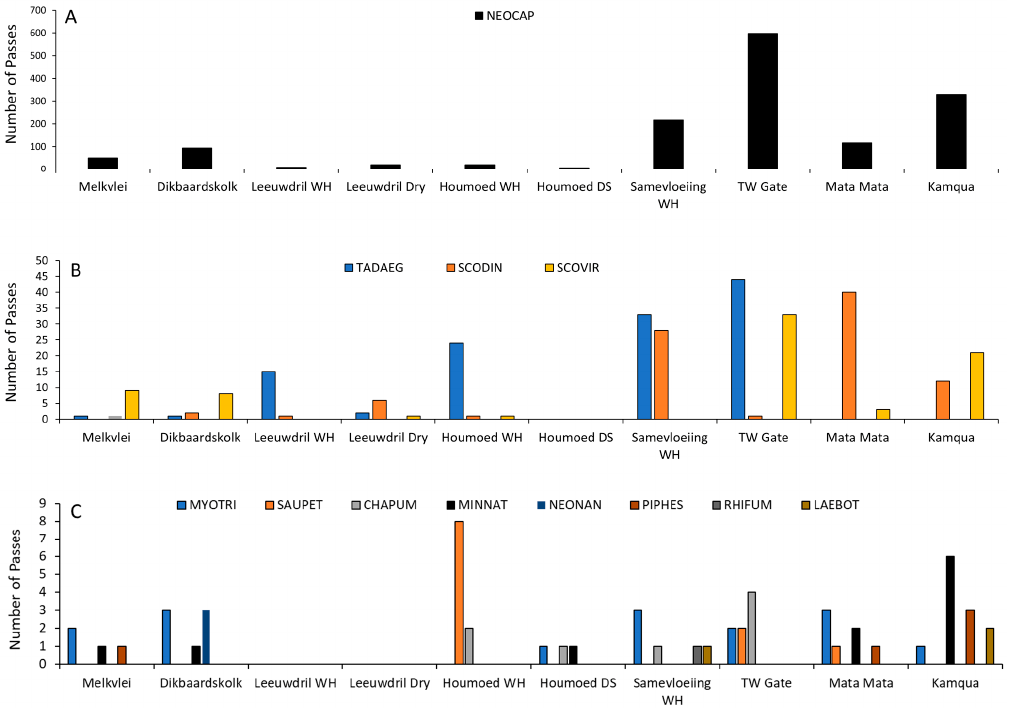
Figure 7. Distribution of activity at each site. ( A ) Neoromicia capensis (NEOCAP) was the most abundant species in the park and was found to occur at all sites; ( B ) Second most common species was Scotophilus dinganii (SCODIN), recorded at eight sites, followed by Tadarida aegyptiaca (TADAEG), Scotophilus viridus (SCOVIR), and Scotophilus viridus (SCOVIR), which were found at seven of 10 sites; ( C ) Least number of passes were recorded for Myotis tricolor (MYOTRI), Sauromys petrophilus (SAUPET), Chaerephon pumilus (CHAPUM), Miniopteris schriebersii (MINSCH), Neoromicia nana (NEONAN), Pipistrellus hesperidus (PIPHES), Rhinolophus fumigatus (RHIFUM), and Laephotis botswanae (LAEBOT). WH = Water Hole, DS = Dry Site, TW = Twee Rivieren gate, a dry site paired with Samevloeiing